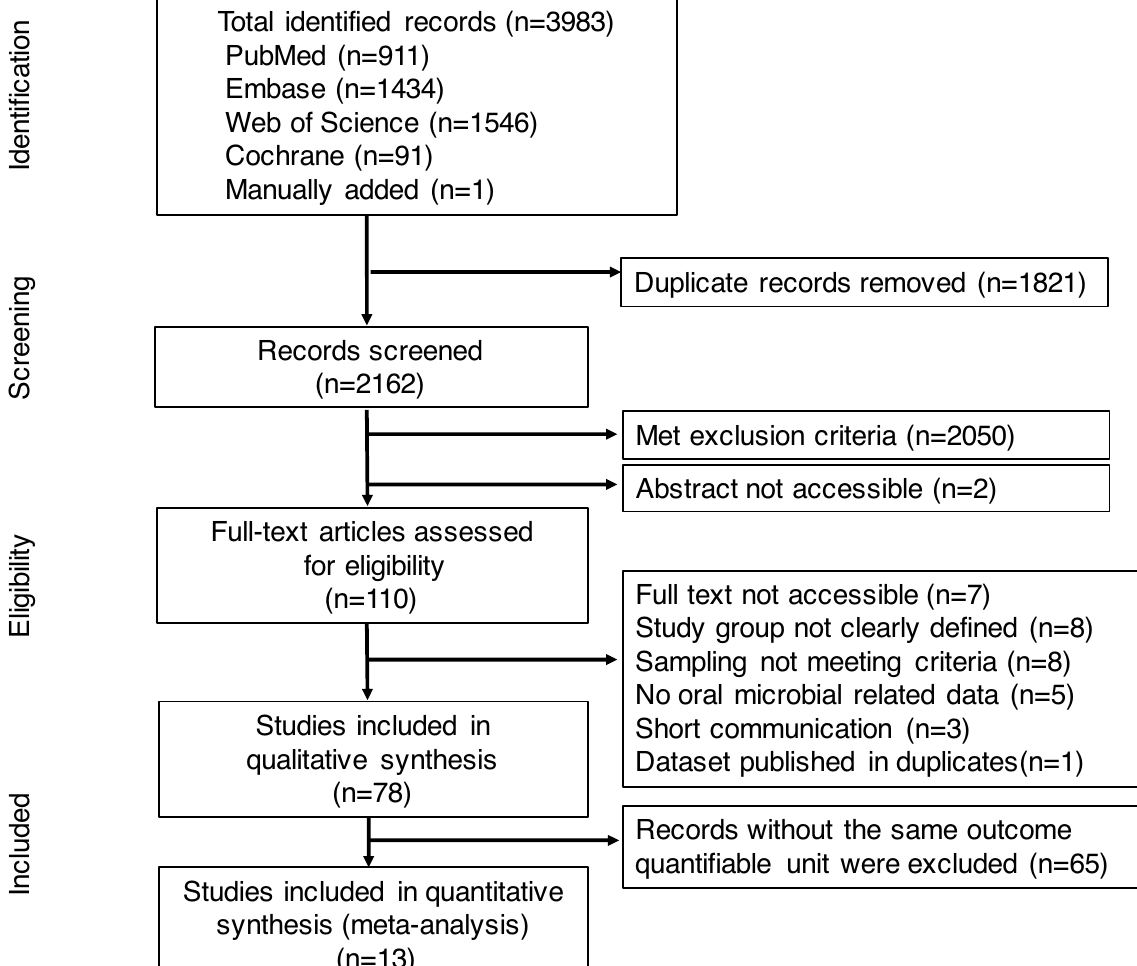
Figure 1. Flow diagram of study identification. The 4-phase preferred reporting items for systematic reviews and meta-analyses (PRISMA) flow diagram was used to determine the number of studies identified, screened, eligible, and included in the systematic review and meta-analysis (http:// www. prisma- state ment.